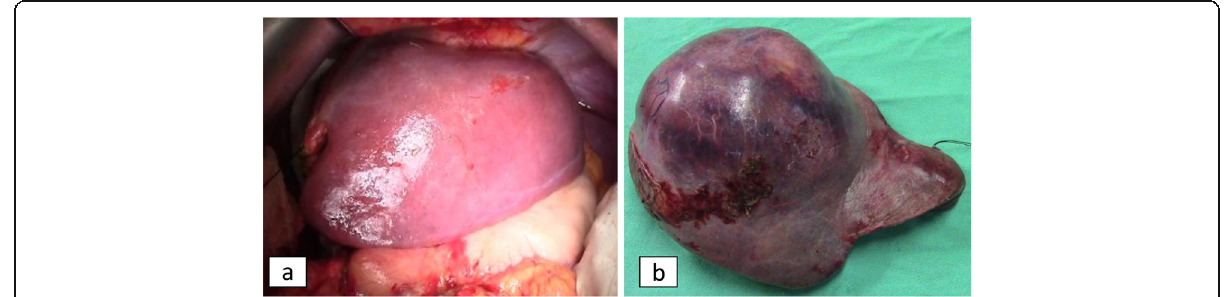
Fig. 3 a FLR after ALPPS 2. b Right trisectionectomy